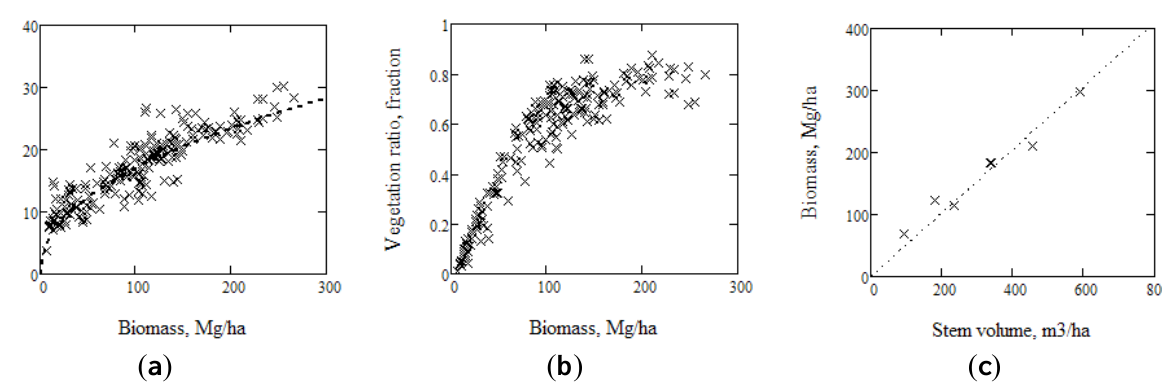
Figure 2. ( a ) Stand-wise values of LiDAR heights (H95) versus LiDAR-based biomass and an allometric equation relating basal-area-weighted mean height to biomass, see Equation (3); ( b ) LiDAR vegetation ratio versus LiDAR-based biomass, and ( c ) biomass versus stem volume for the seven 80 m × 80 m plots with single tree